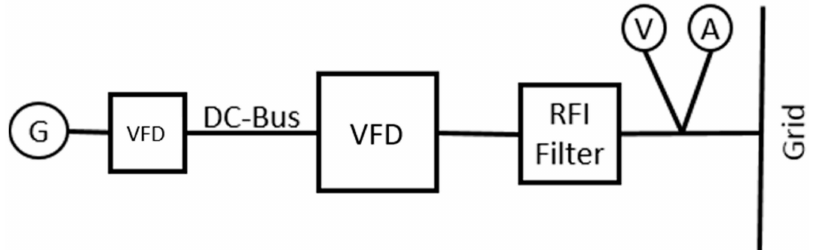
Figure 5. Single line drawing of the Lir NOTF emulator showing the placement of the voltage and current